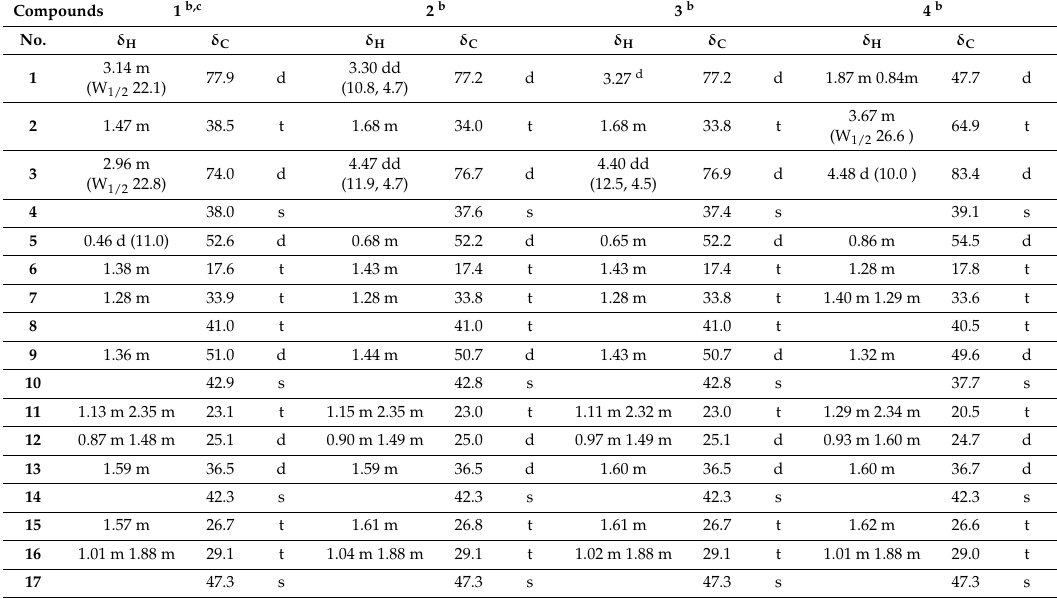
Table 1. 1 H- and 13 C-NMR spectroscopic data for compounds 1 – 4 a ( δ in ppm, DMSO, J in Hz).